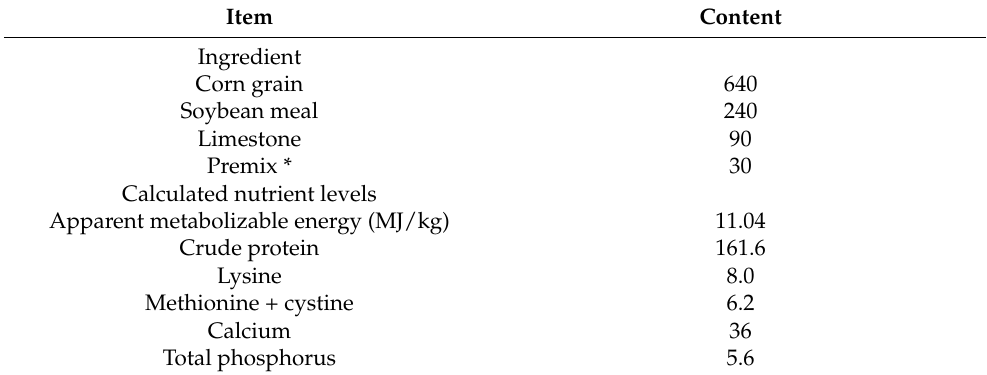
Table 1. Composition and nutrient level of basal diet (g/kg, as fed basis unless otherwise stated).